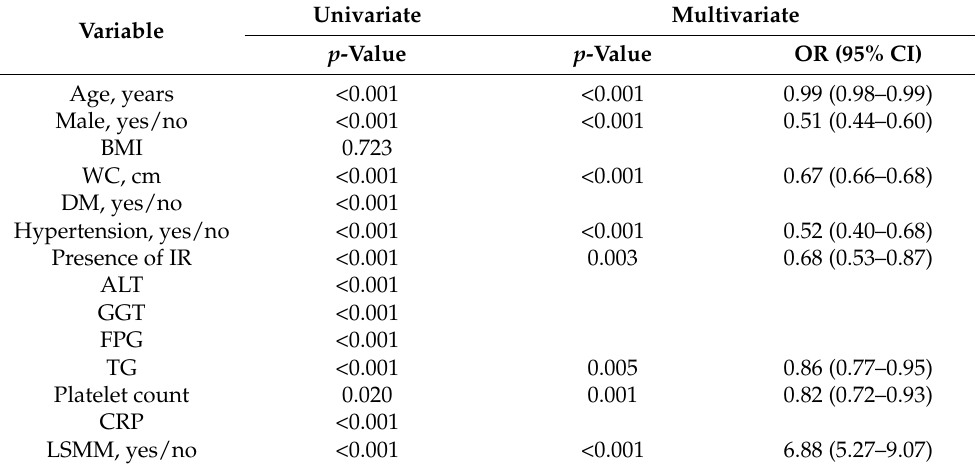
Table 2. Risk factors associated with lean NAFLD patients.